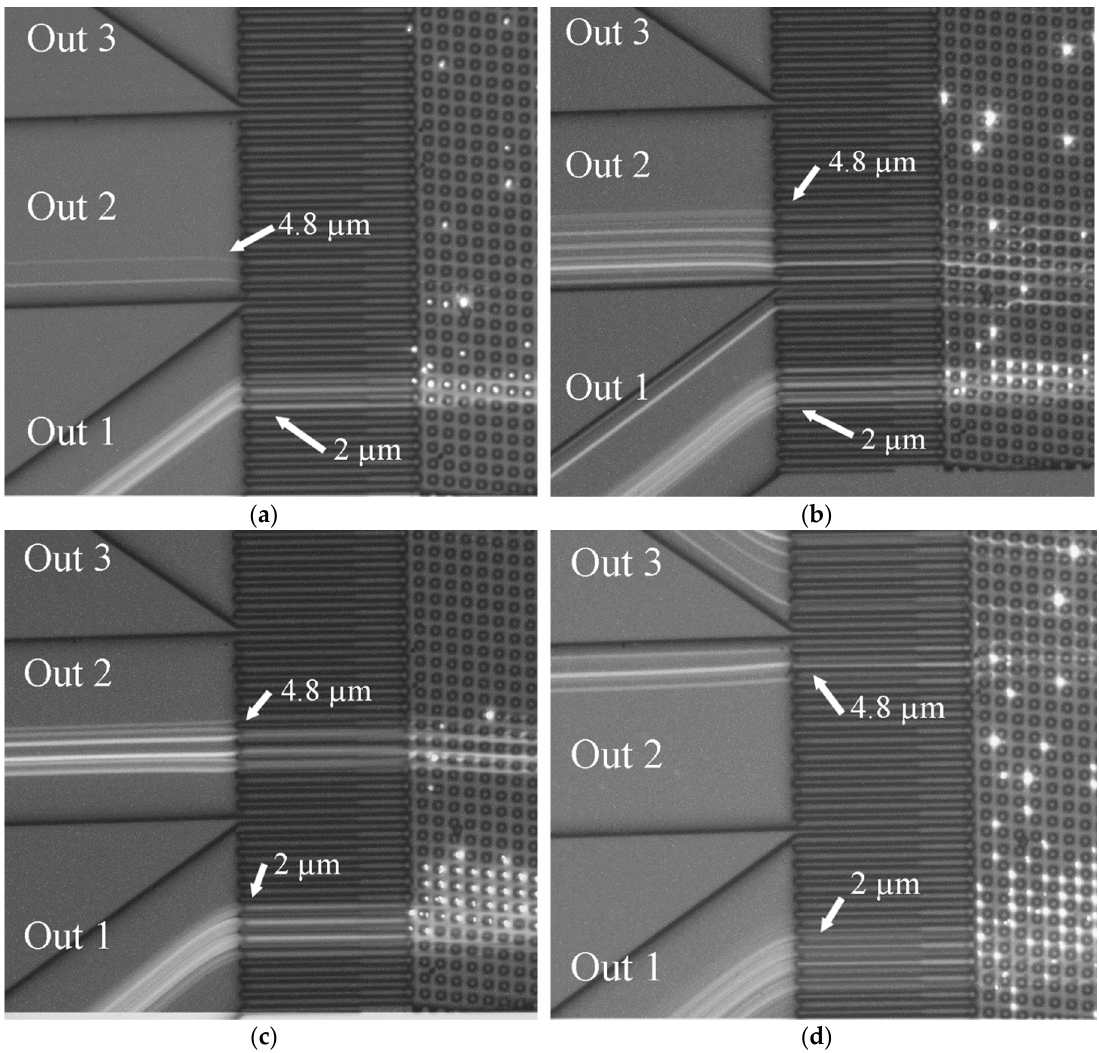
Figure 16. Overlay of 200 video frames with the white light image of the DLD chip areas showing the fractionation position at the end of the array as obtained with fluorescent particles at a size of 2 µm and 4.8 µm for different velocities (Reynolds numbers). ( a ) Re = 0.5; ( b ) Re = 10; ( c ) Re = 15; ( d ) Re = 25.